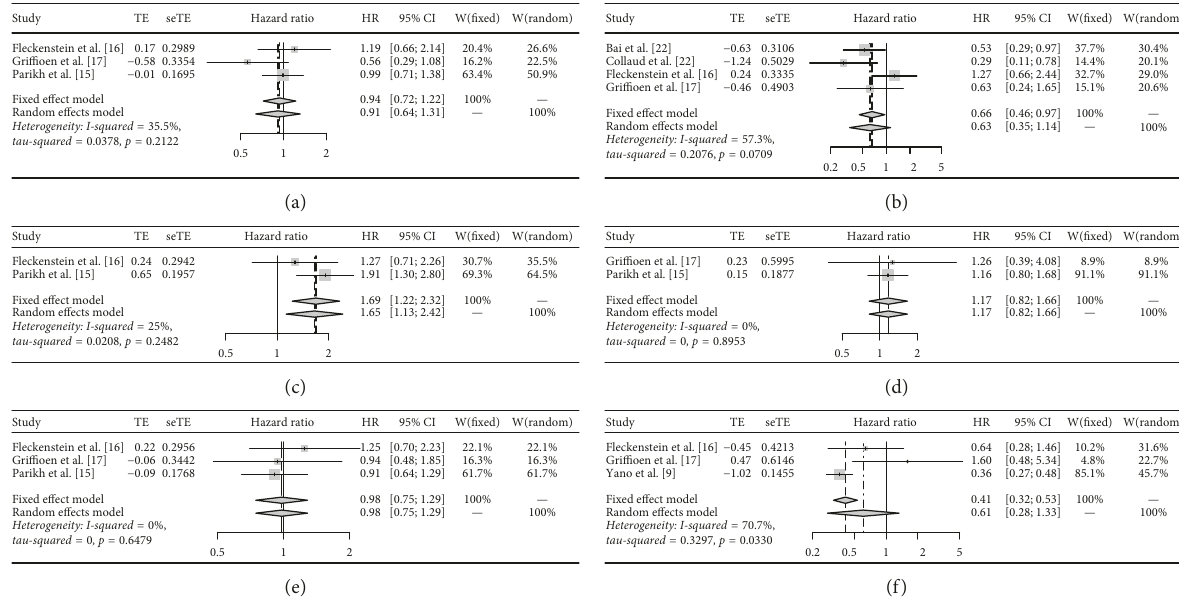
Figure 2: Meta-analysis for the association of survival of oligometastatic non-small-cell lung cancer patients with sex (a), stage (b), nodal status (c), smoke (d), age (e), and histology (f).